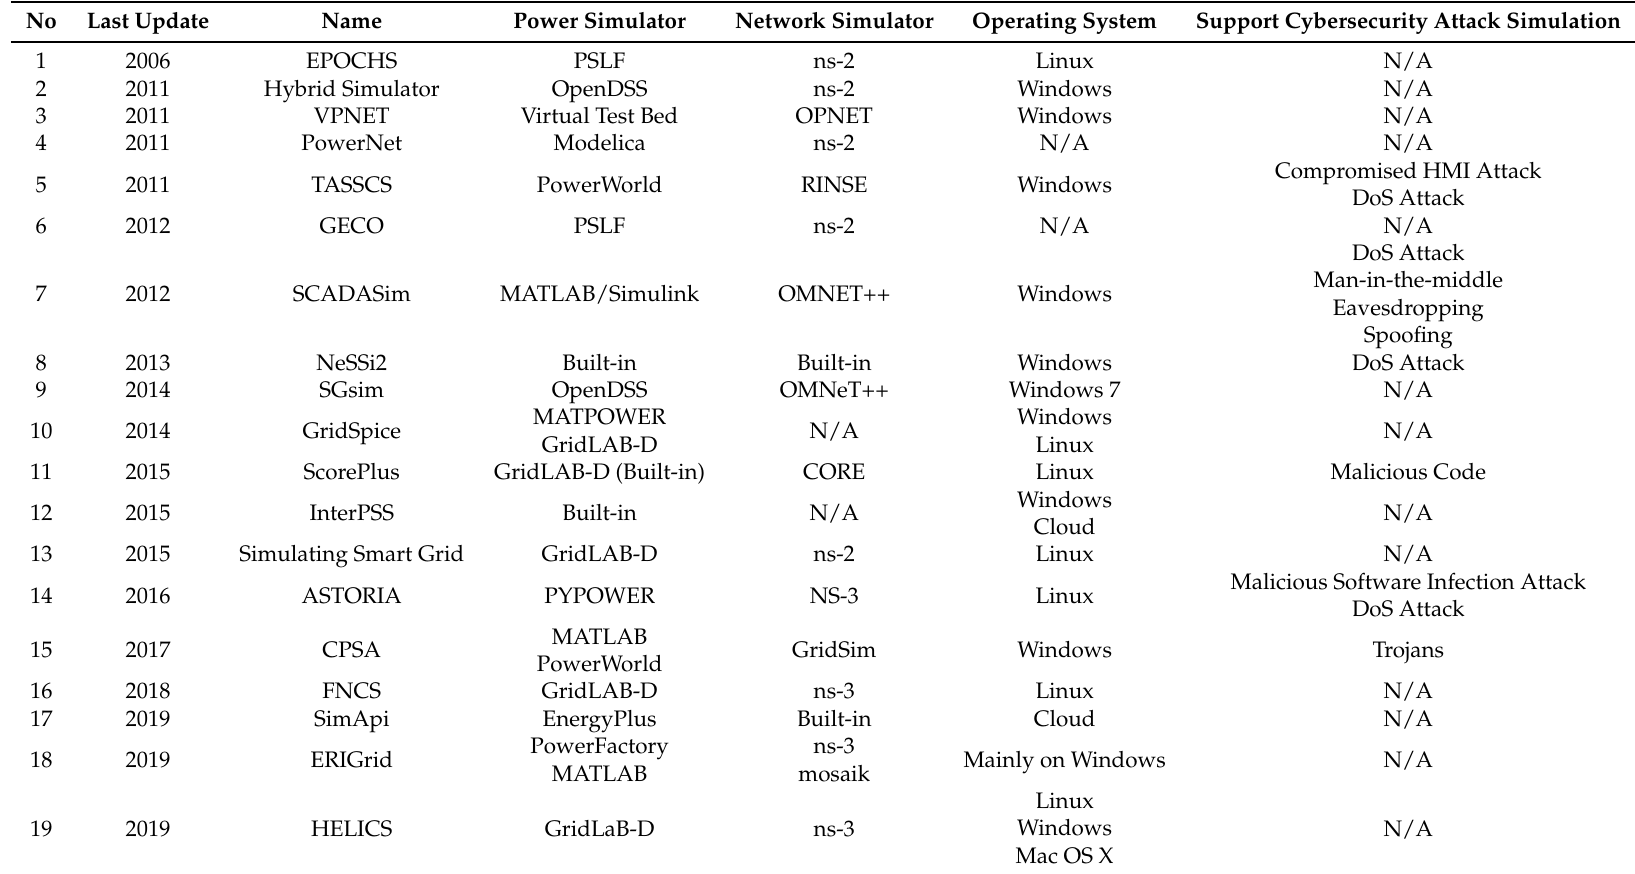
Table 1. Co-simulation tools for smart